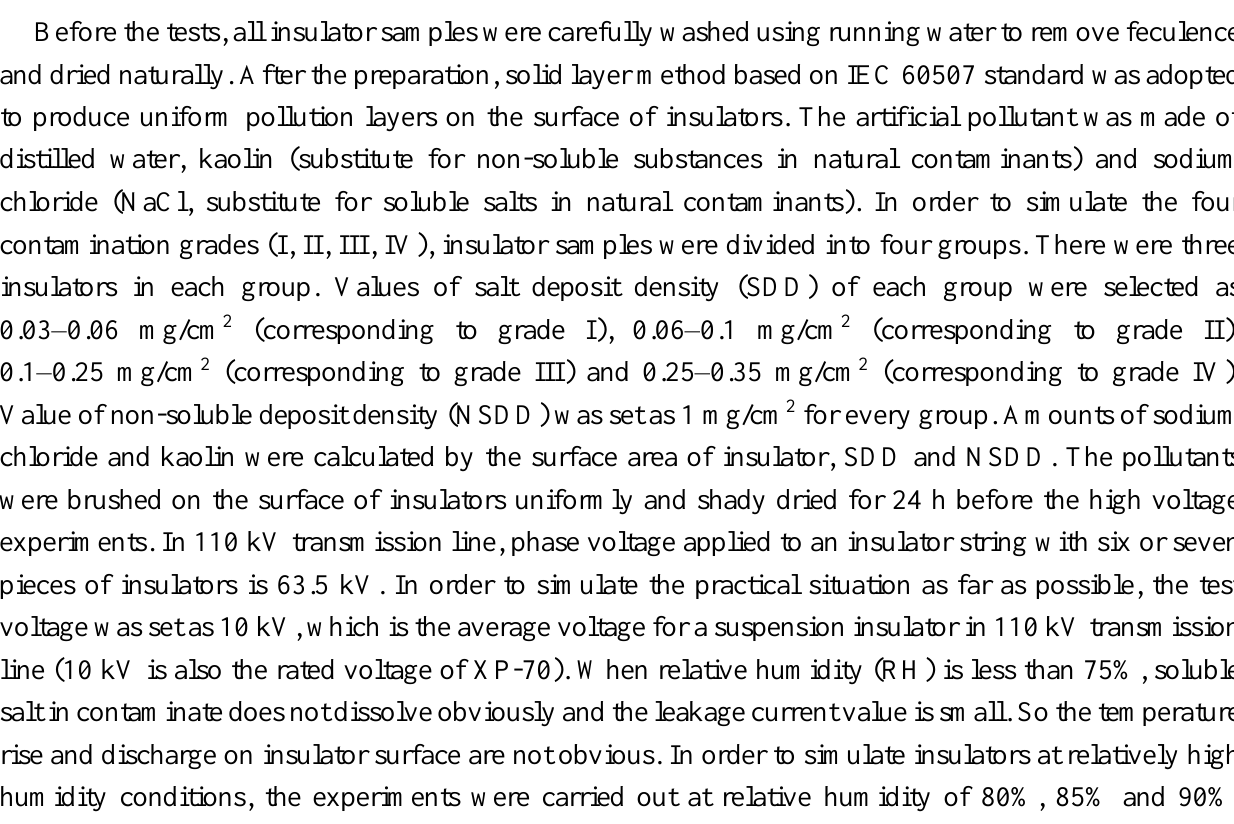
Figure 4. Schematic diagram of the test